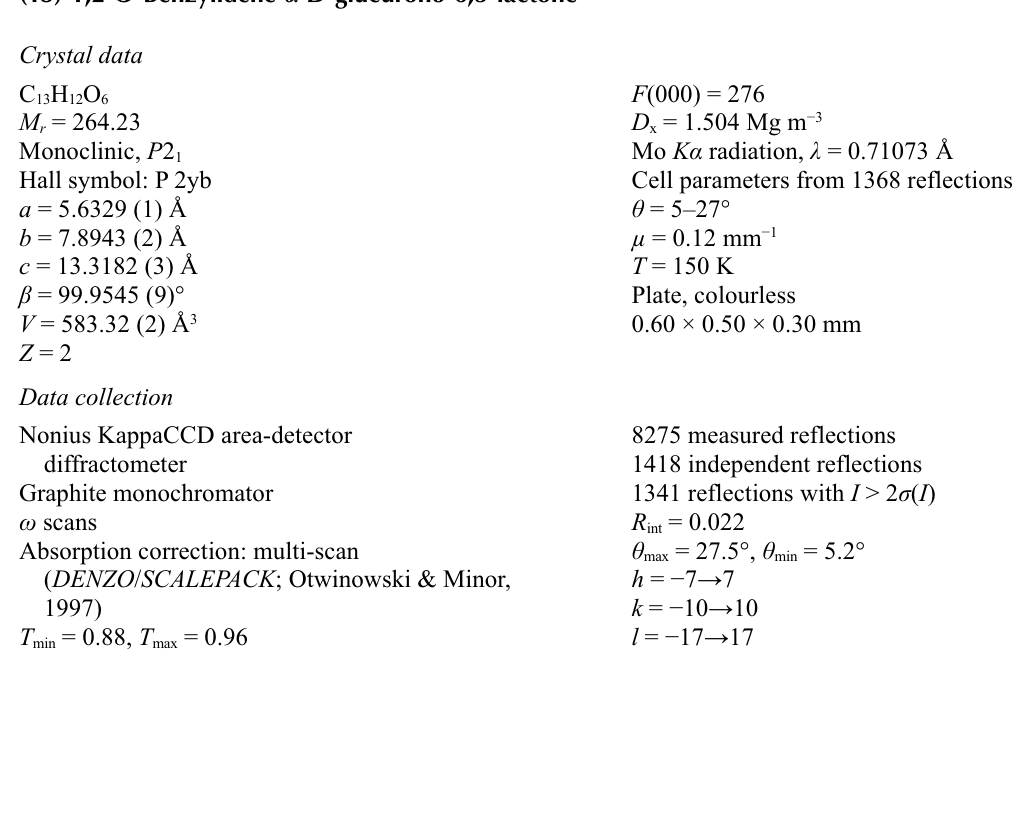
Figure 4 Packing diagram showing alternating layers of hydrogen bonded chains of molecules. (1 S )-1,2- O -Benzylidene- α - D